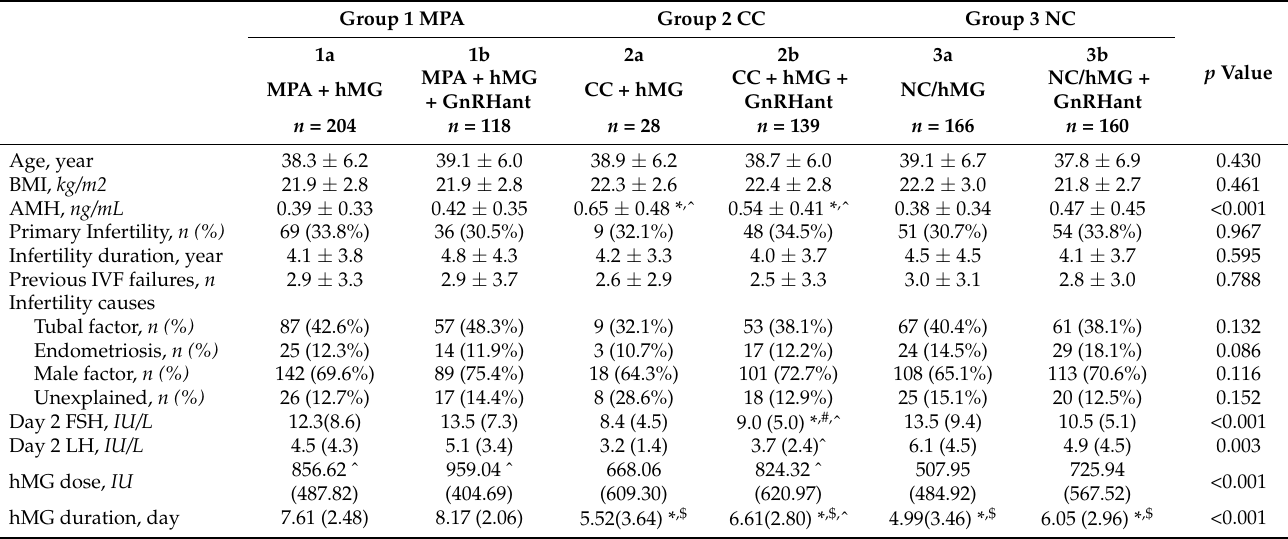
Table 1. Patient Characteristics.